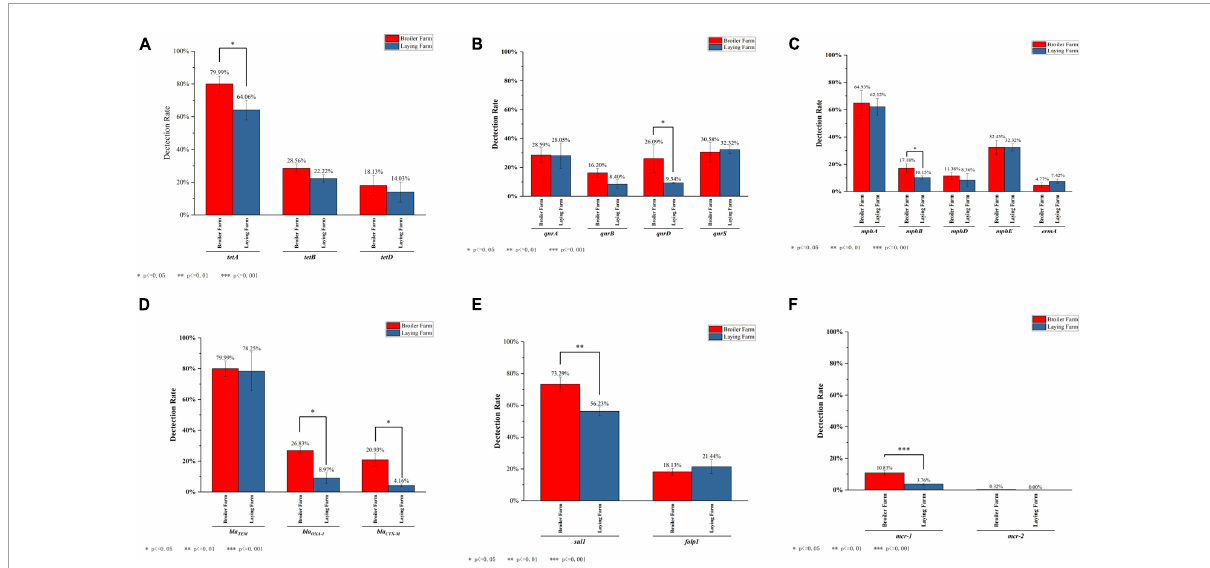
FIGURE7 The detection rate of ARGs which are banned in layers or both. (A) The detection rate of tetracyclines resistance genes. (B) The detection rate of quinolones resistance genes. (C) The detection rate of macrolides resistance genes. (D) The detection rate of β -lactam resistance genes. (E) The detection rate of sulfonamide resistance genes. (F) The detection rate of polymyxins resistance